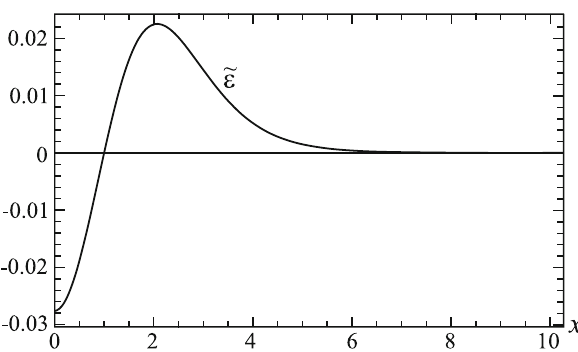
Fig. 2 The profile of the dimensionless flux tube energy density ˜ ε ≡ g 2 ε/φ 4 ( 0 ) fromEq.(7)rewrittenintermsofthedimensionlessvariables given before Eq. (8)